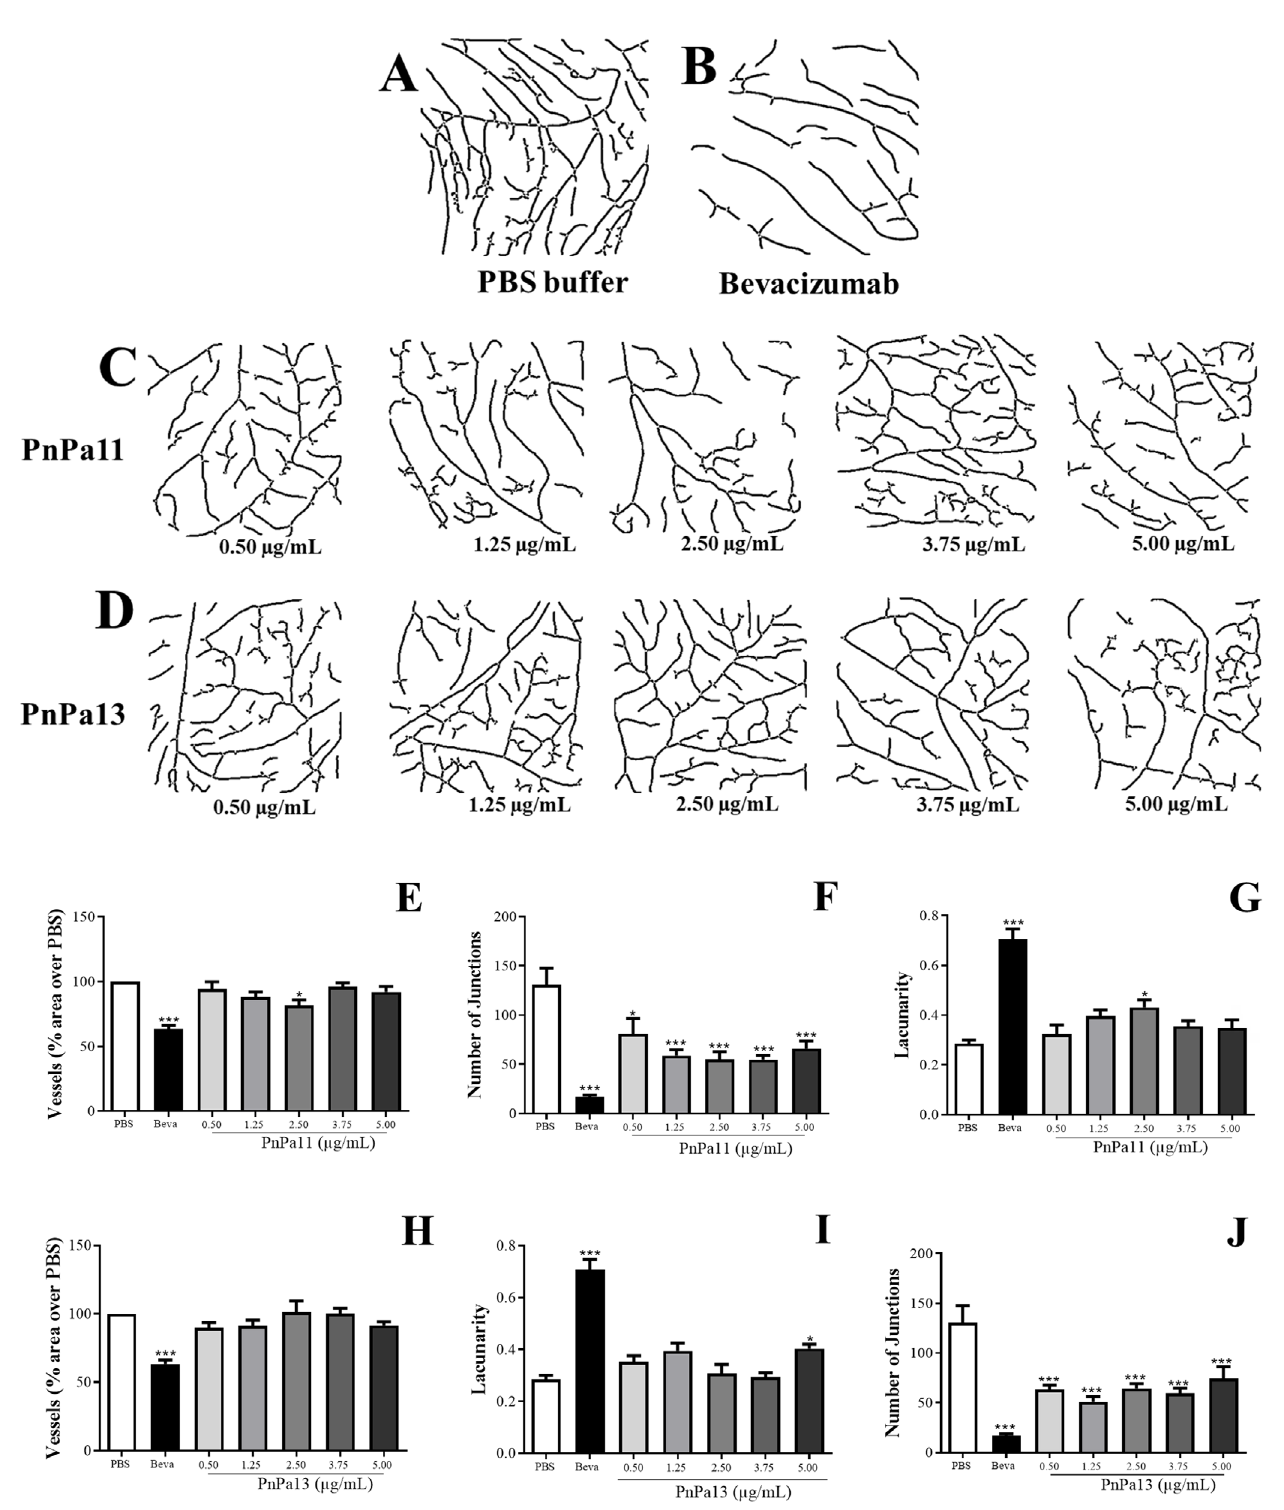
Figure 2. Microphotography of the vascular structure of CAM after injection by PnPa11 and PnPa13 peptides at different concentrations (0.50-5.00 µg/mL). (A- D) The photographs were obtained after processing procedure used to characterize the CAM vascular network. Graphs show the measure of vascularization after exposure to (E-G) PnPa11 or (H-J) PnPa13. Comparison among groups was analyzed using one-way ANOVA followed by Tukey post-test (n = 10). The data are represented by mean ± SD. The saline group was set as 100%. *Significant difference as compared to saline-group (*p < 0.05, ***p <